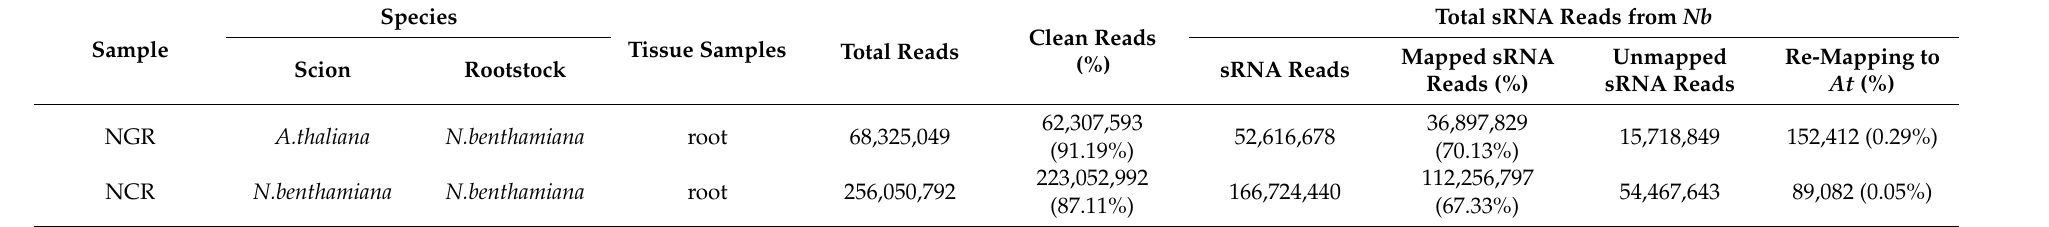
Table 2. Deep sequencing of small RNA libraries from Nb rootstock and mapping to At and Nb genome.